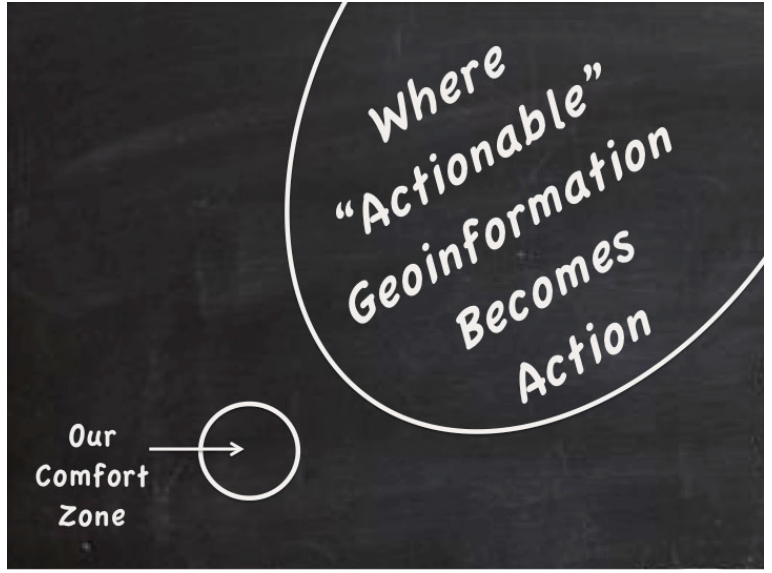
Figure 7. Humanitarian practitioners need to step outside of their comfort zone in order to turn allegedly actionable geoinformation into real-world action. Games can